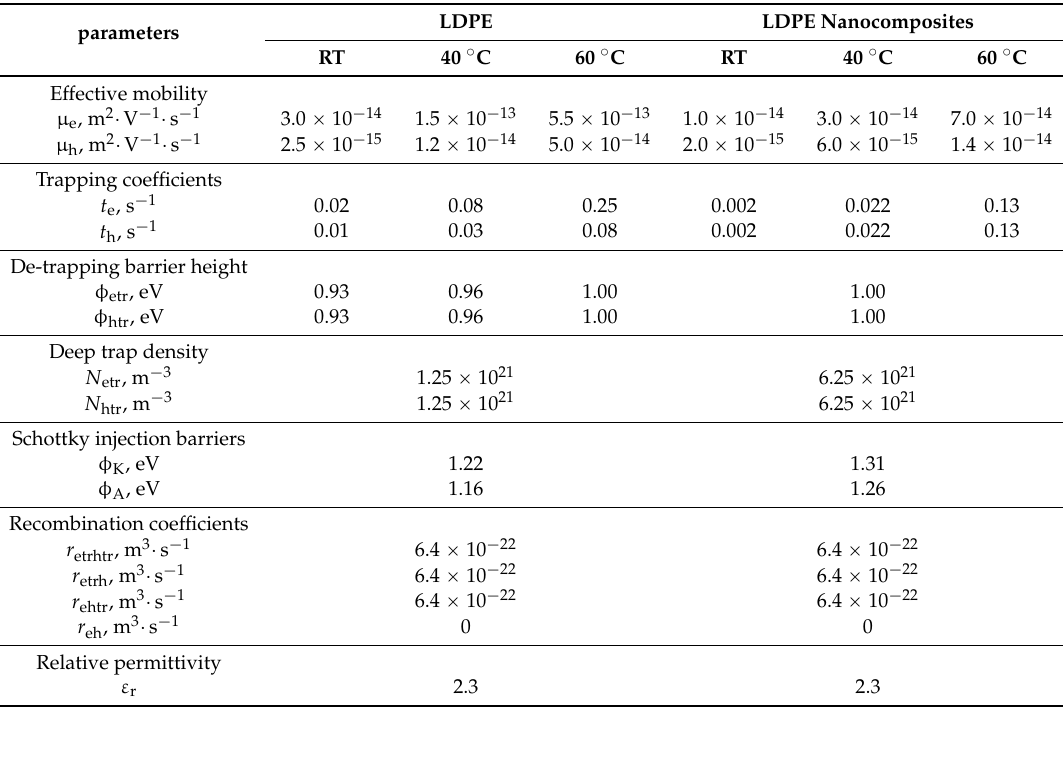
Table 1. Parameters used in models for fitting the measured conduction currents on LDPE and its nanocomposites at various temperatures. RT stands for room temperature (~22 °C).